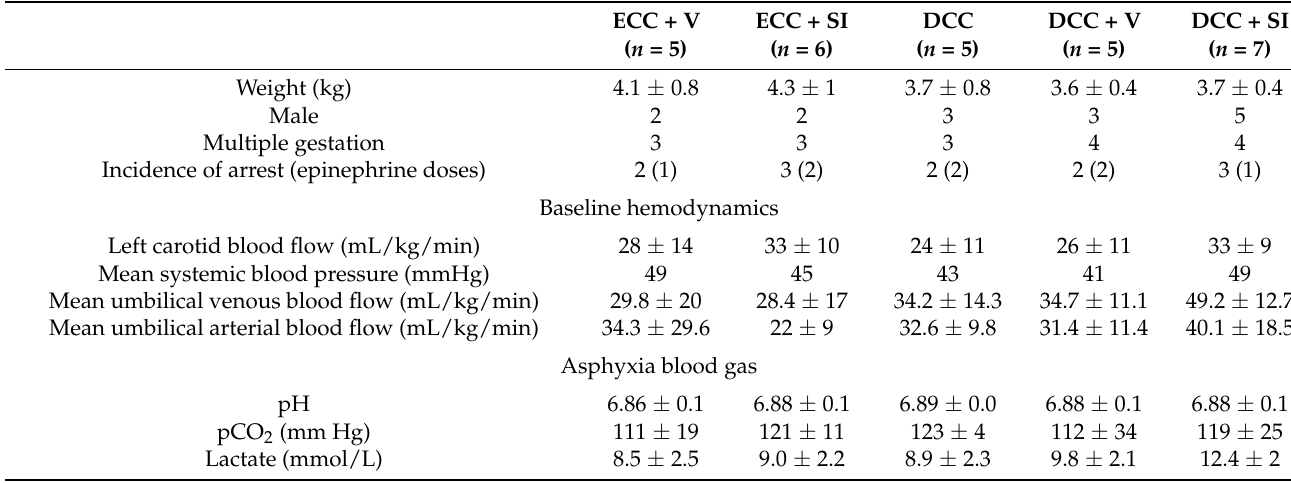
Table 1. Baseline